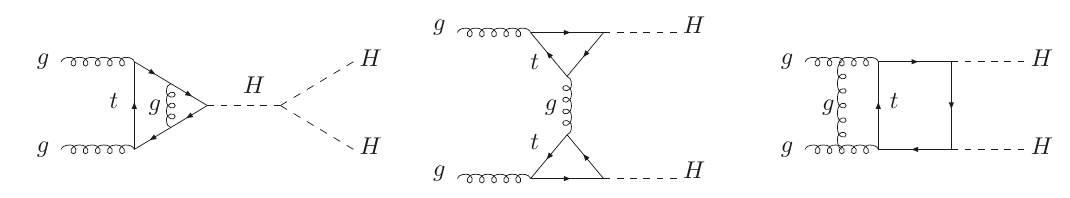
Figure 2 . Typical two-loop triangle (left), one-particle reducible (middle) and box (right) dia- grams contributing to Higgs-pair production via gluon fusion at